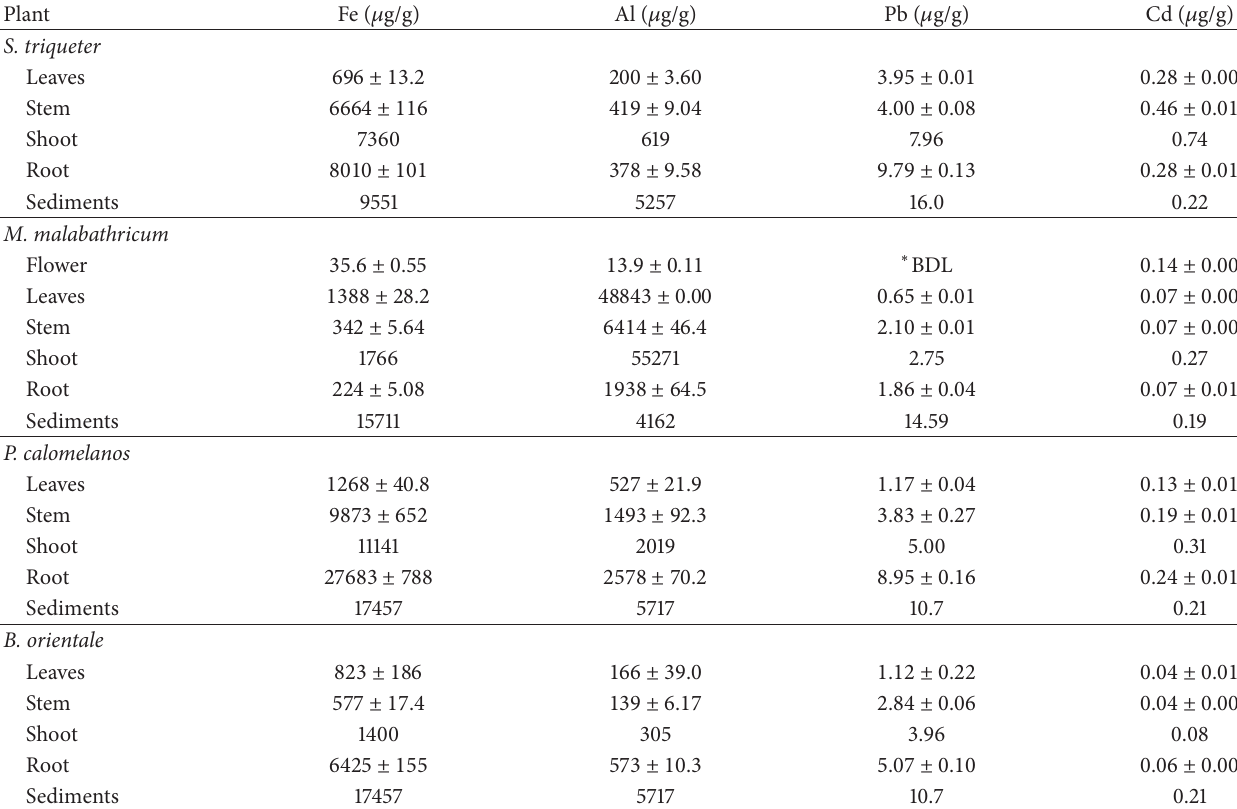
Table 7: Heavy metals concentrations in different plant species collected from within Bukit Besi ex-mine.